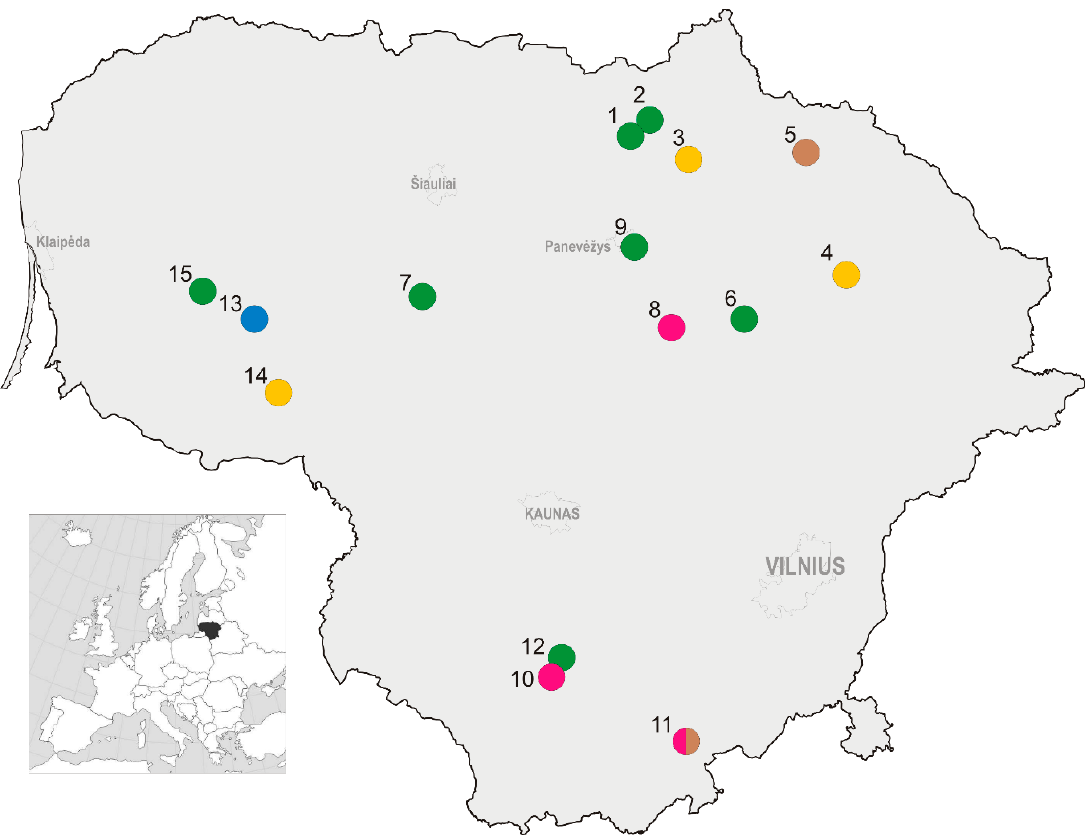
Figure 1. Location of the study sites in Lithuania: 1—Aukštikalniai, 2—Pajiešmeniai, 3—Gaiži ū nai, 4—Užpaliai, 5—Kalpokai, 6—Šeimyniškiai, 7—Šedbarai, 8—Šiekštin ė s, 9—Dembava, 10—Užubaliai, 11—Bar č iai, 12—Luksn ė nai, 13—Naujasis Obelynas, 14—Gaur ė , 15—Kv ė darna. Crop type is indicated by color: green—apple orchards, brown—plum orchards, magenta—raspberry plantations, yellow—currant plantations, and blue—highbush blueberry plantations. Location coordinates are not presented to ensure privacy of the owners.